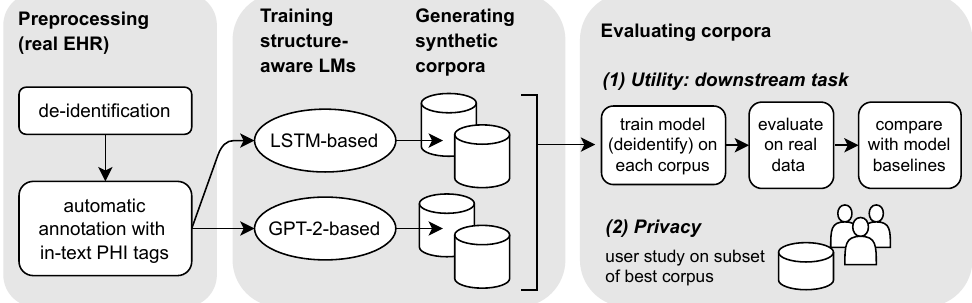
Figure 2. Overview of this study. (1) Raw, EHR text is automatically de-identified and annotated with in-text PHI labels. (2) Pre-processed text is used to train two “structure-aware” language models: an LSTM and GPT-2. (3) Using different decoding strategies, two synthetic corpora are generated from each language model. (4) Synthetic text is evaluated regarding utility and privacy. (4.1) Utility is measured by comparing the performance of machine learning models trained on synthetic data with models trained on real data. (4.2) For the privacy evaluation, ROUGE n-gram overlap and retrieval-based BM25 scoring is used to select the most similar real documents. Afterwards, the synthetic-real document pairs are presented to participants in a user